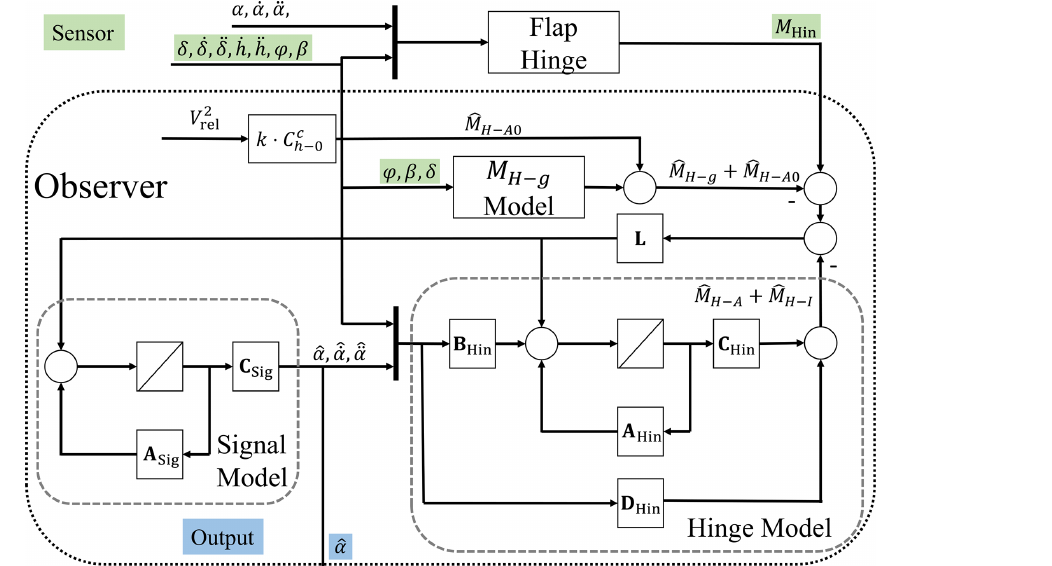
Figure 4. Representation of the linear observer for a constant V rel . The required sensors and the observer output are marked with a green and blue background,